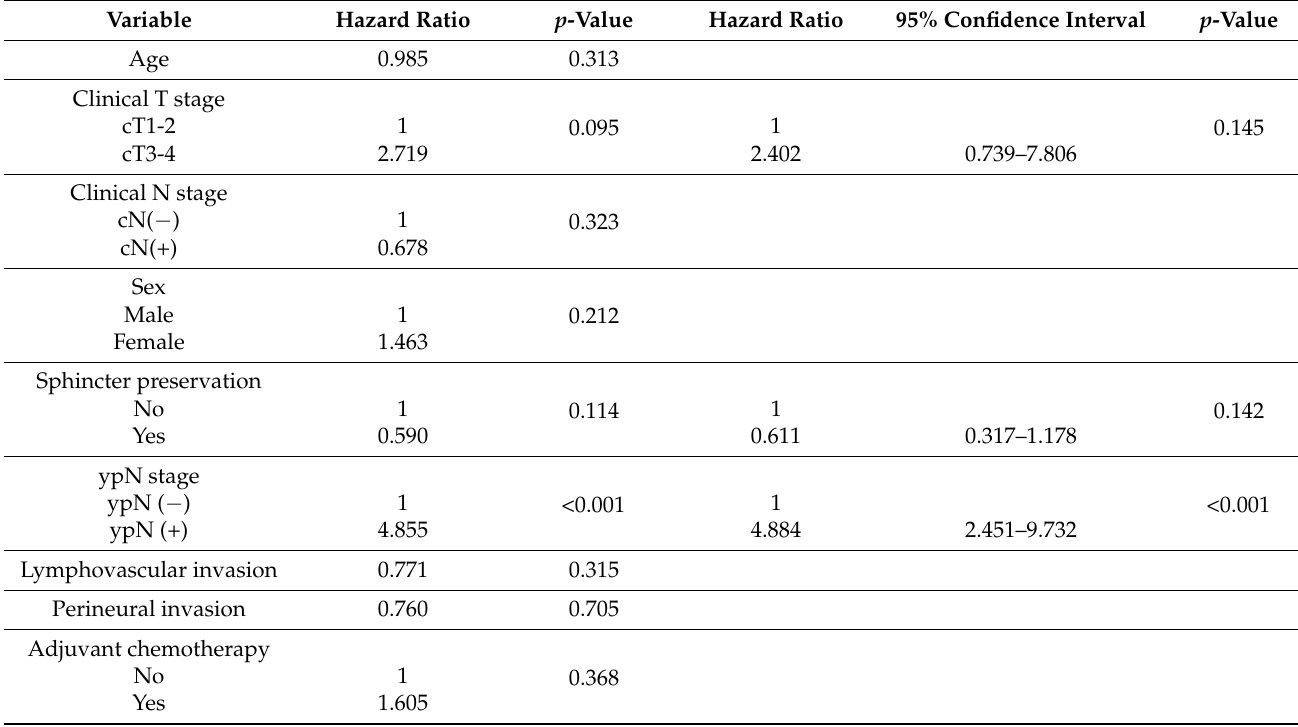
Table 4. Factors associated with recurrence-free survival in ypT0-1 rectal cancer treated radical resection after preopera- tive